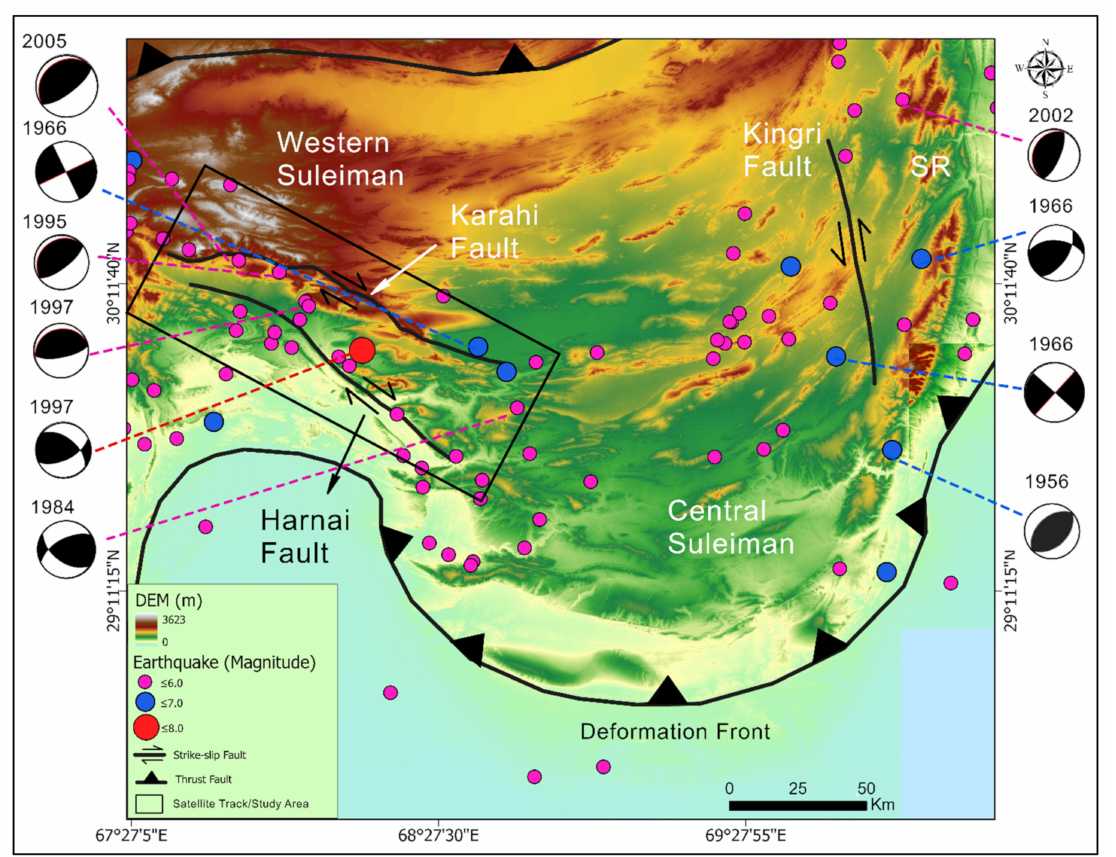
Figure 3. Map showing the structural subdivision of the SFTB into the eastern, central, and western Ranges. The black rectangle indicates the satellite track (Sentinel-1A). Earthquakes with a magnitude greater than 5 and their focal mechanism solution derived from USGS are plotted to show their distribution across the SFTB [26]. A high density of earthquakes is plotted in the western Suleiman near to Quetta Syntaxis/Sibi reentrant. The foreland propagation of the deformation front is also prominent. SR, Suleiman